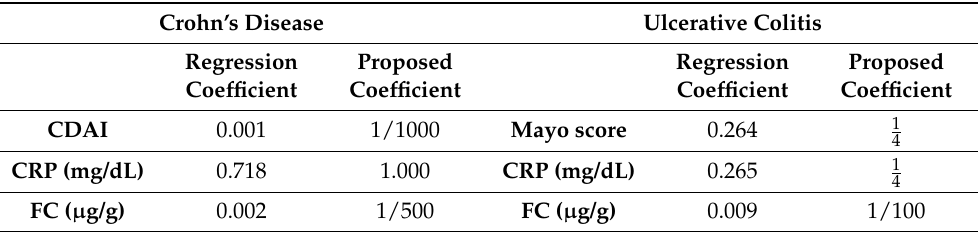
Table 6. Linear regression coefficients obtained by logistic regression and those proposed for fur- ther